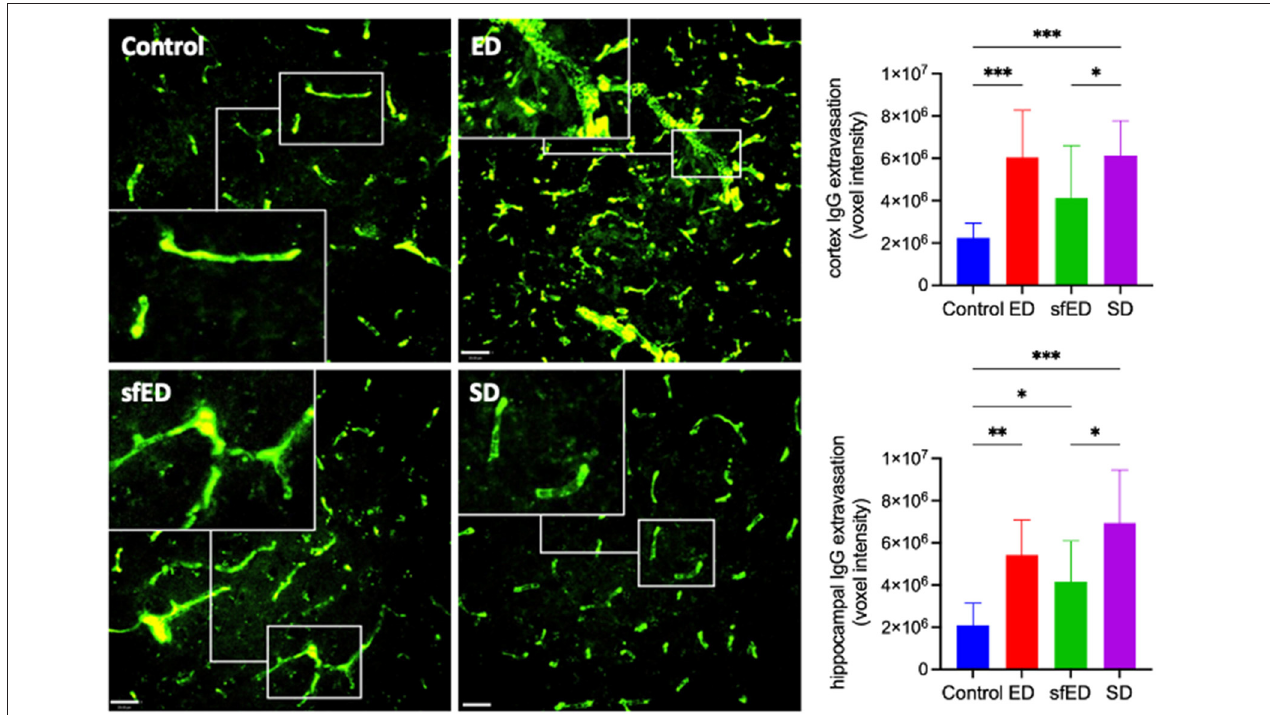
FIGURE 1 | Cerebrovascular integrity measures. Twenty µ m sections of brain tissue for each treatment group were stained for IgG (green) and measured under a confocal fluorescent microscope. A representative image of cortex from each group is shown for both stains at low power magnification (20x) (scale bar = 20 µ m). The IgG images are accompanied by a high power magnified image (40x) in the white rectangular sub-frame within each low power image. All measures are of voxel intensity and therefore render the data to show relative levels rather than absolute concentrations. Statistical analysis was performed using Kruskal-Wallis test with uncorrected Dunn’s post-hoc analysis ( n = 10; * p < 0.05, ** p < 0.005, *** p <